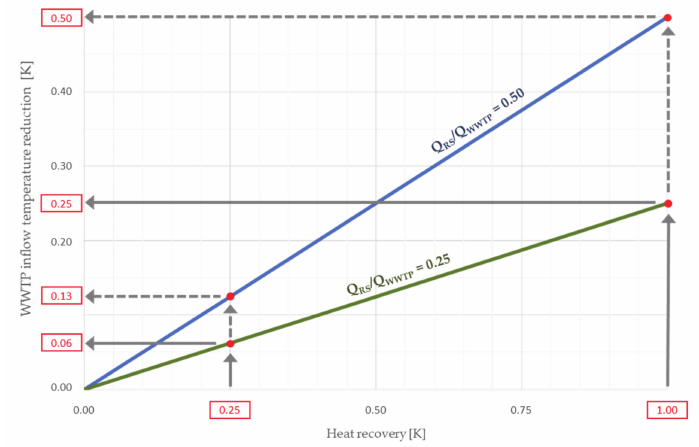
Figure 3. Heat recovery / temperature reduction relationship (own representation, based on